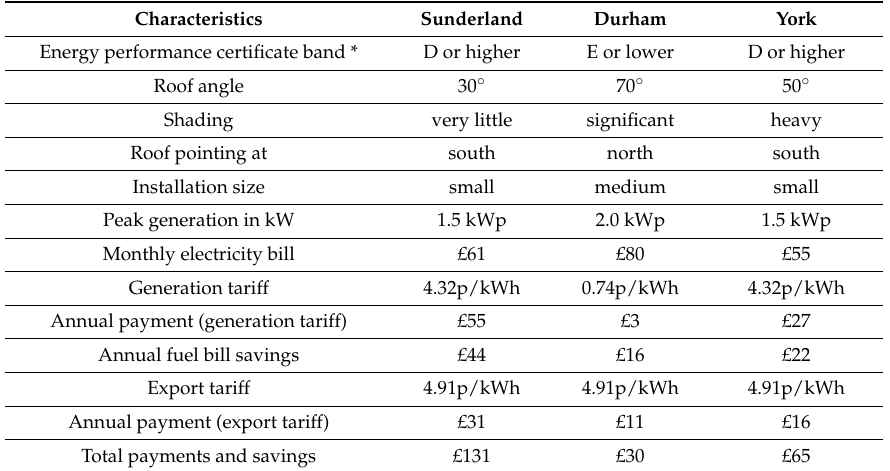
Table 2. UK households’ savings from installing PVs and using the Feed-in Tariff (FITs)